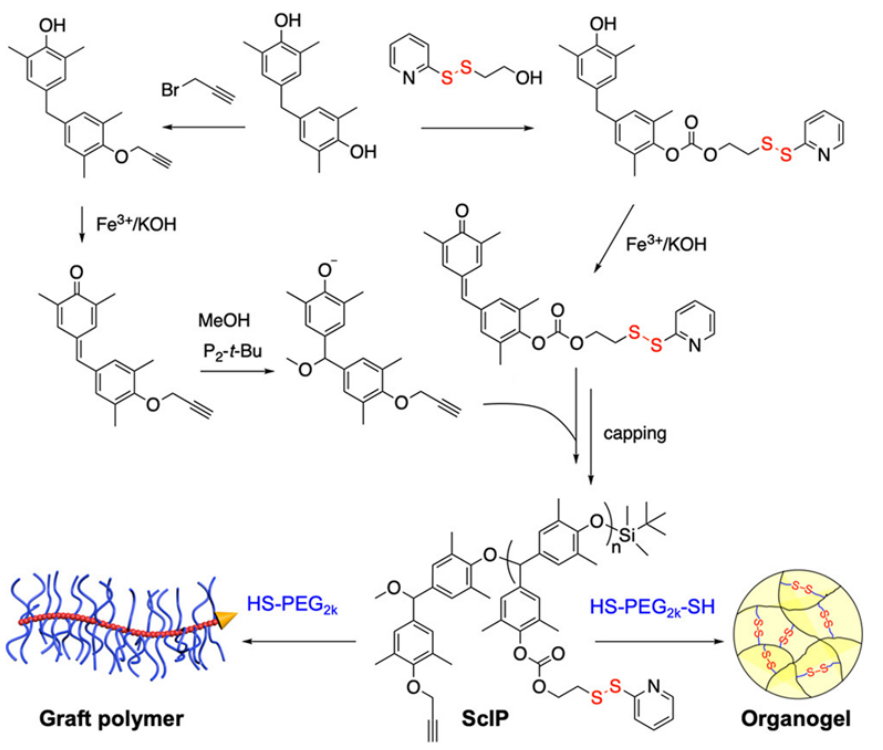
Figure 23. Synthesis of PBE-based ScIPs bearing pyridyl disulfide pendant groups, and their reaction with mono-or bis-mercapto-terminated PEG to form PEG-grafted ScIPs (ScIP- g -PEG) or organogel networks with PEG-disulfide crosslinks. Adapted with permission from [89]. Copyright (2019) American Chemical Society.